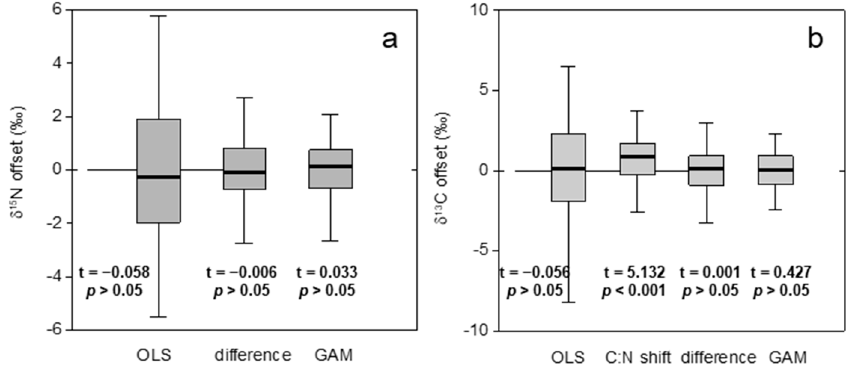
Figure 5. Box plot of the offset in ( a ) δ 15 N or ( b ) δ 13 C between measured values in dried samples and values estimated by ordinary least squares regression (OLS), the relative shift in C:N ratio (C:N shift), subtraction of the mean difference between formalin-preserved and dried samples (difference), or by generalised additive models (GAM). Box: 25 and 75% quartiles; whiskers: 1.5 × the interquartile range; horizontal line: median. The values of the Student’s t statistic (t) and the significance ( p ) of differences between the mean offset and zero were indicated in each case.